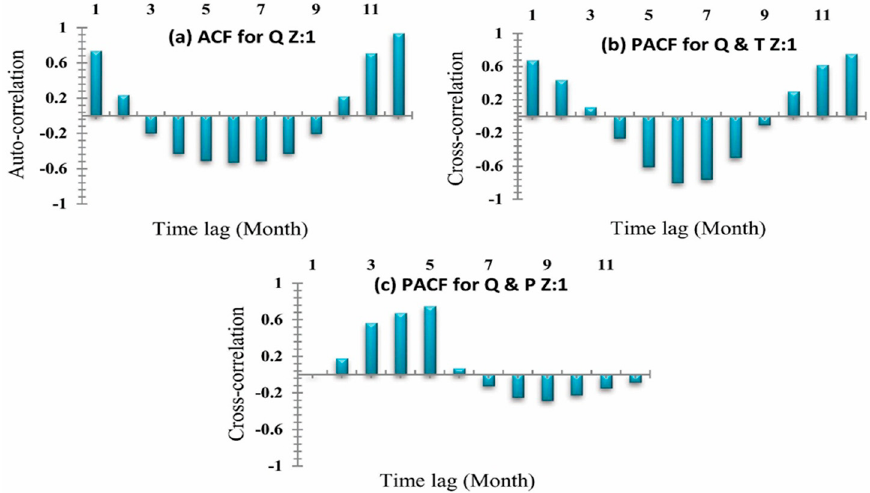
Figure 10. Zone One ( a ) Auto-correlation coefficients for stream-flow. ( b ) Cross-correlation coefficient for stream-flow and temperature. ( c ) Cross-correlation coefficient for stream-flow and rainfall.